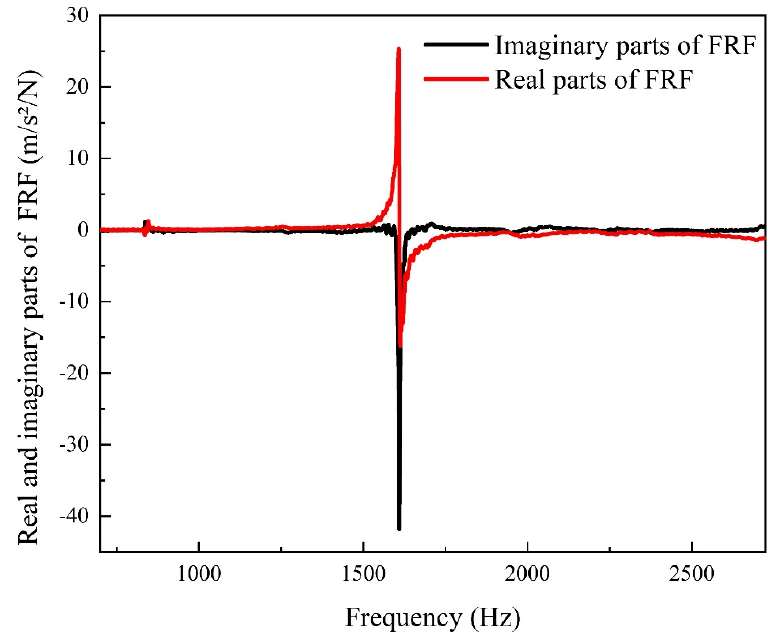
Figure 8. FRF of the stainless steel 304 bar sample.